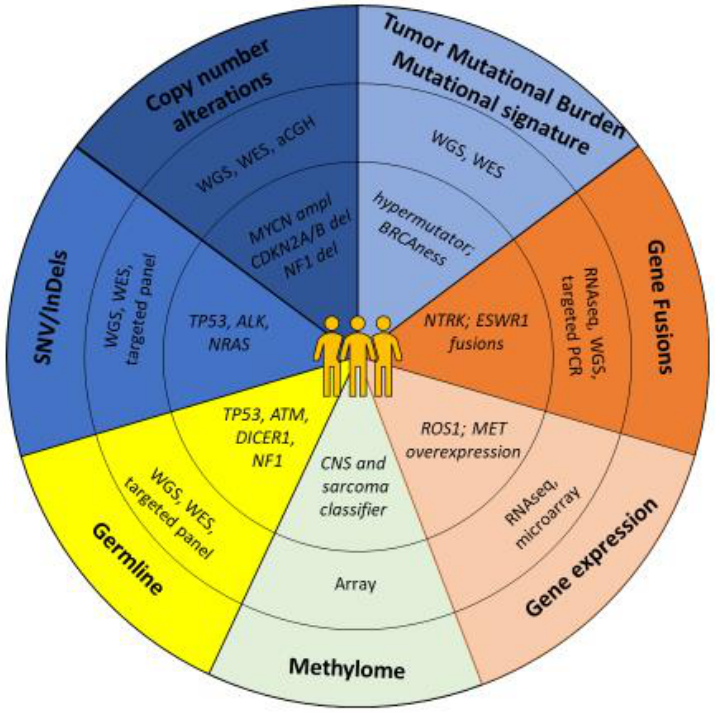
Figure 1. Precision medicine: techniques used with examples in pediatric oncology.